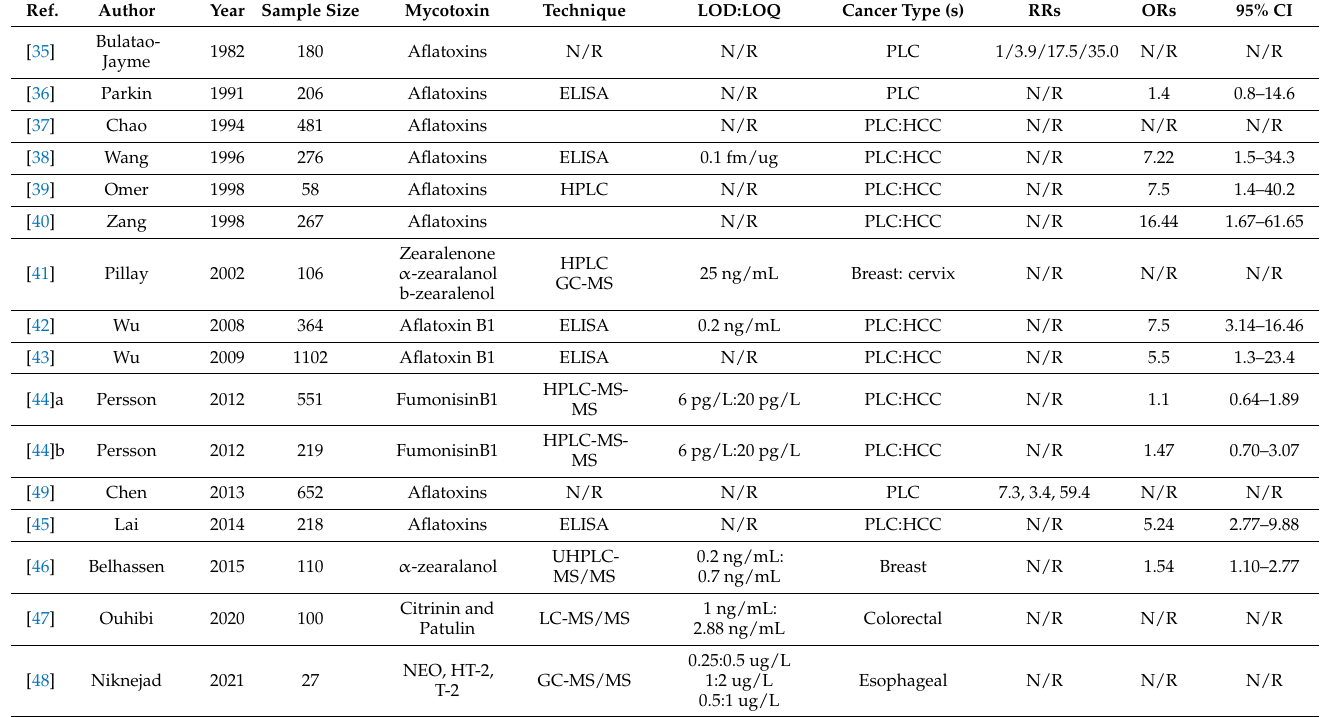
Table 3. Summary of findings on association between mycotoxin-linked mutations and cancer